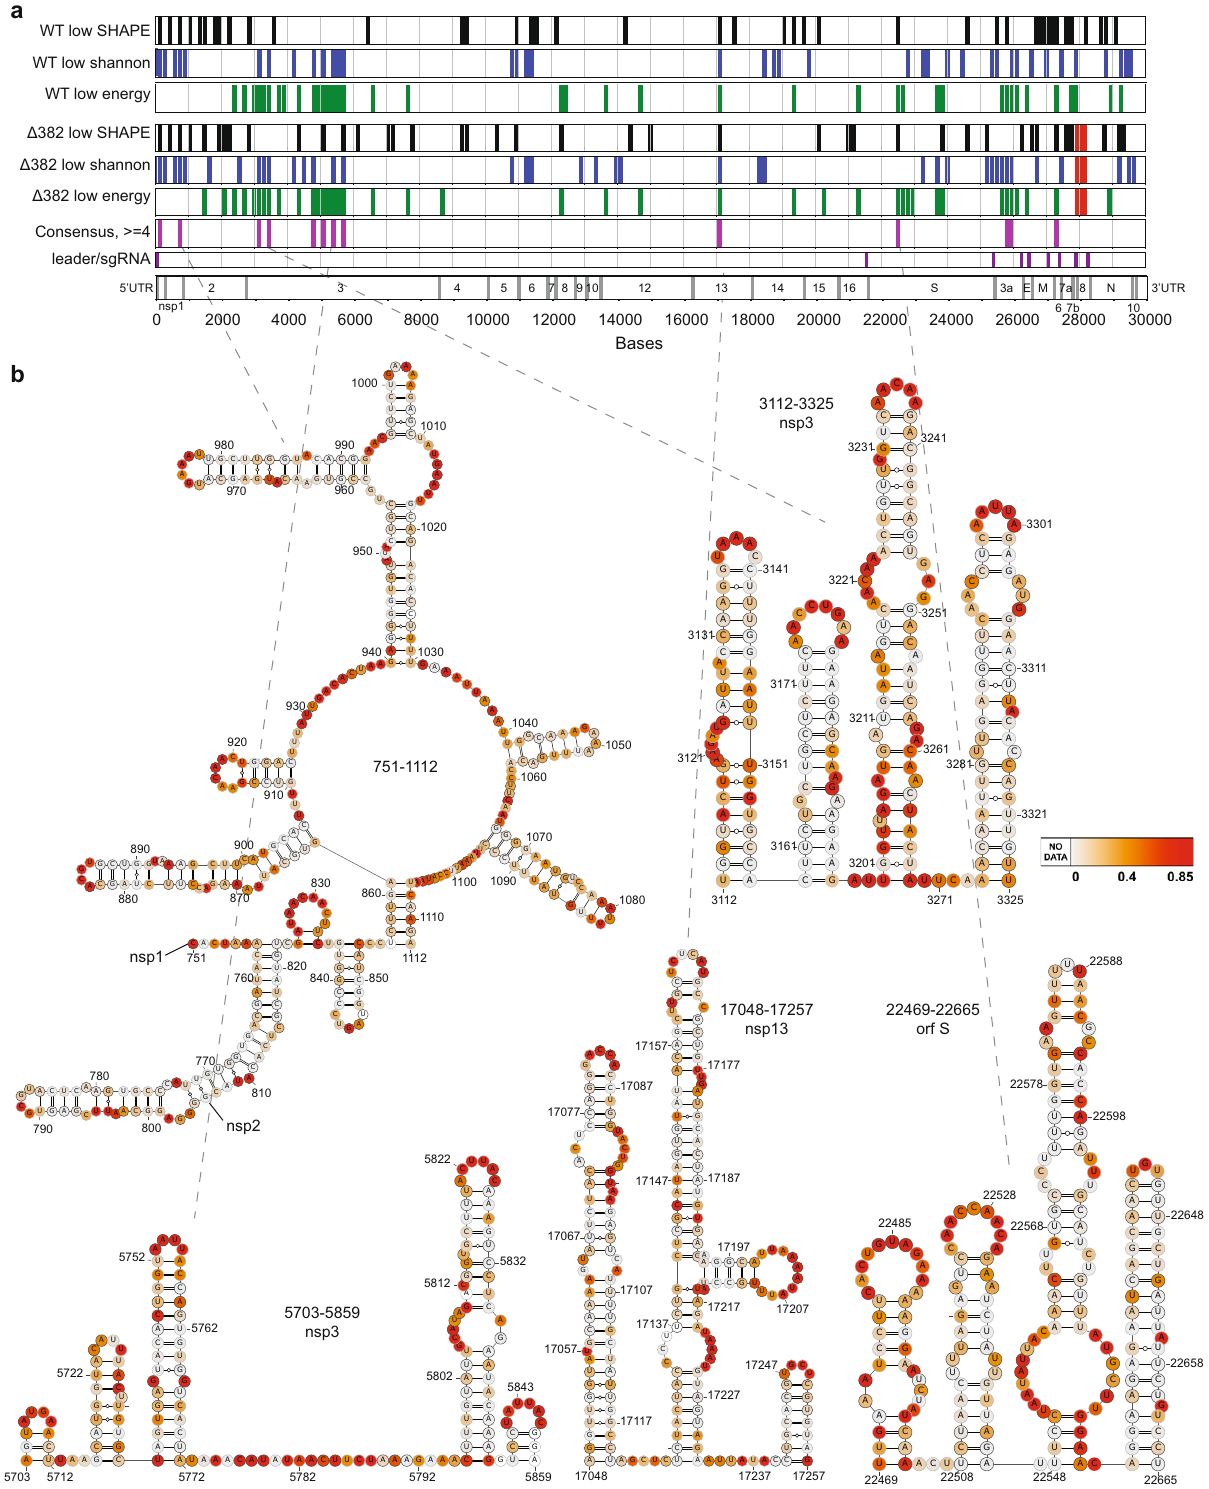
Fig. 2 SHAPE-MaP identi fi es functional structural elements along the SARS-CoV-2 genome. a Regions (150 bases) with the lowest 20% SHAPE reactivity (in black), Shannon entropy (blue), and greatest difference (top 20%) between actual and shuf fl ed energies (green) are shown along both the WT and Δ 382 genomes. 12 consensus regions are consistently highlighted (4/6) across both WT and Δ 382 genomes and are shown in fuchsia. The red box indicates the deletion region in the Δ 382 genome. b Structure models of 5 consensus were generated using the program RNAstructure 54 , using SHAPE-MaP reactivities as constraints, and visualized using VARNA 57 . The SHAPE-reactivities are mapped onto the structure models. Source data are provided as a Source Data fi